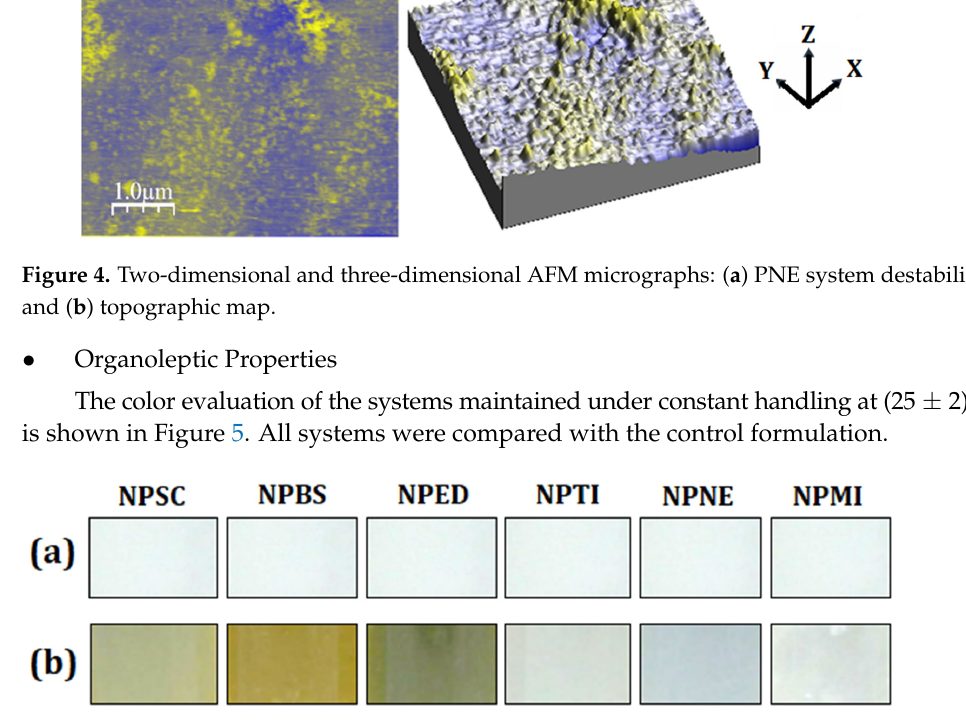
Figure 5. Color evaluation of the systems maintained under constant handling at (25 ± 2) °C: ( a ) control system, and ( b ) systems after evaluation.